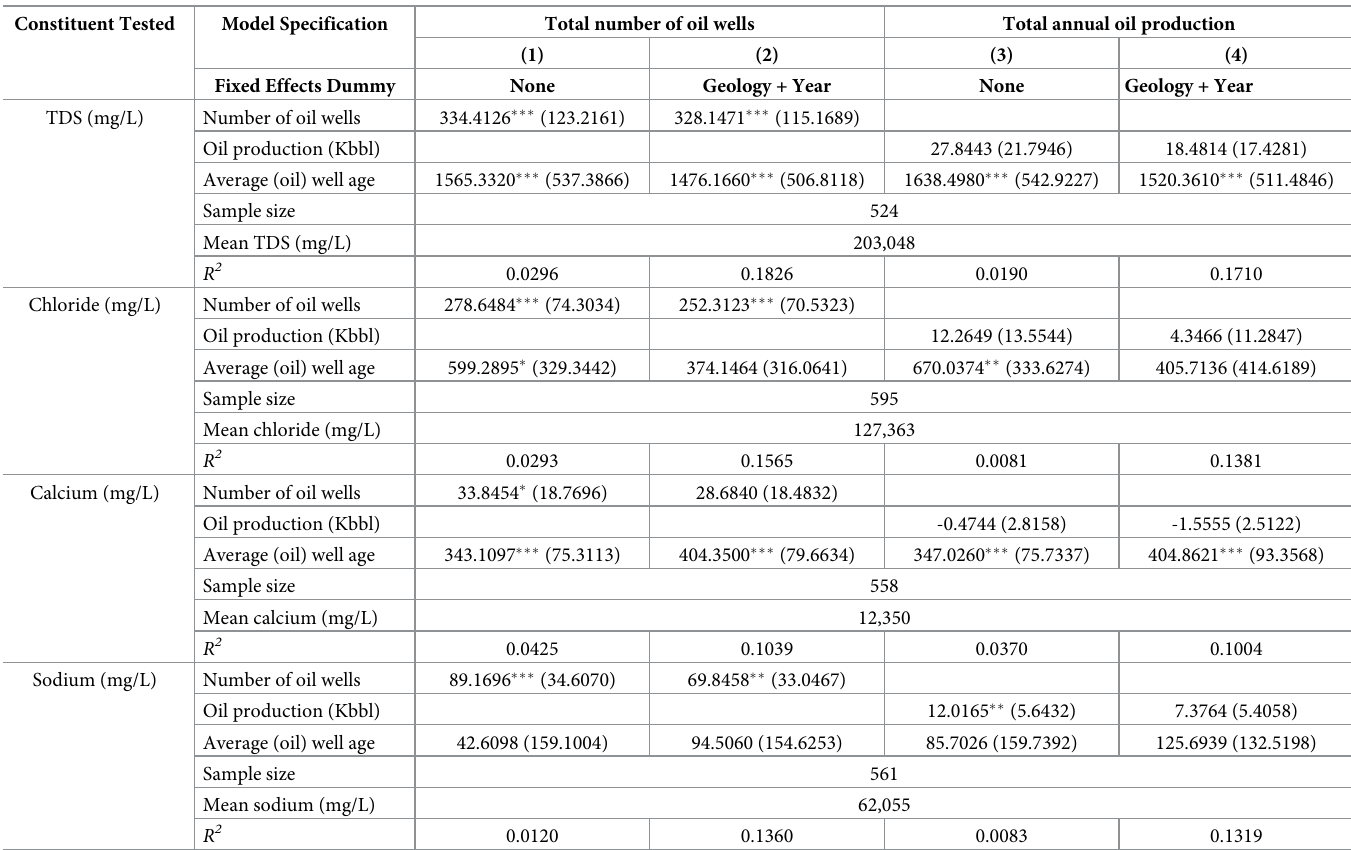
Table 1. Regression of groundwater constituent levels on nearby oil production (sample period: